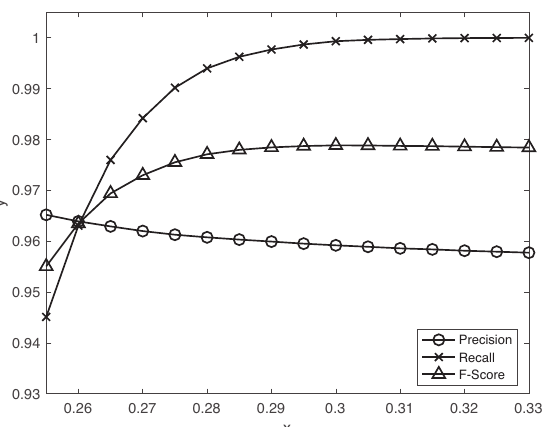
Figure 5. Precision, recall, F-score as a function of different decision thresholds θ = 0.25, . . . ,0.33 of the autoencoder.